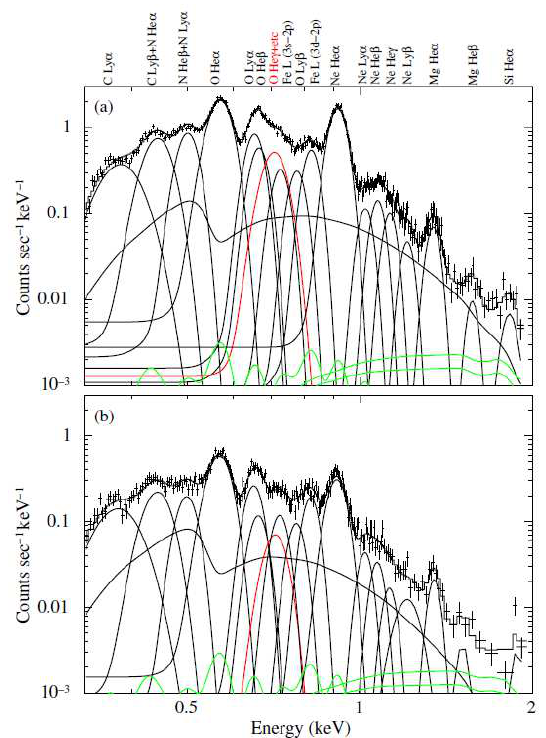
Figure 2: Non-X-ray background subtracted spectrum of a northeastern region of the Cygnus Loop SNR taken with Suzaku along with the best-fit model consisting of a bremsstrahlung plus Gaussians (Katsuda et al., 2011). Line identifications are given on top of the upper panel. The Gaussian shown in red represent the CX emission. The X-ray background components are shown in